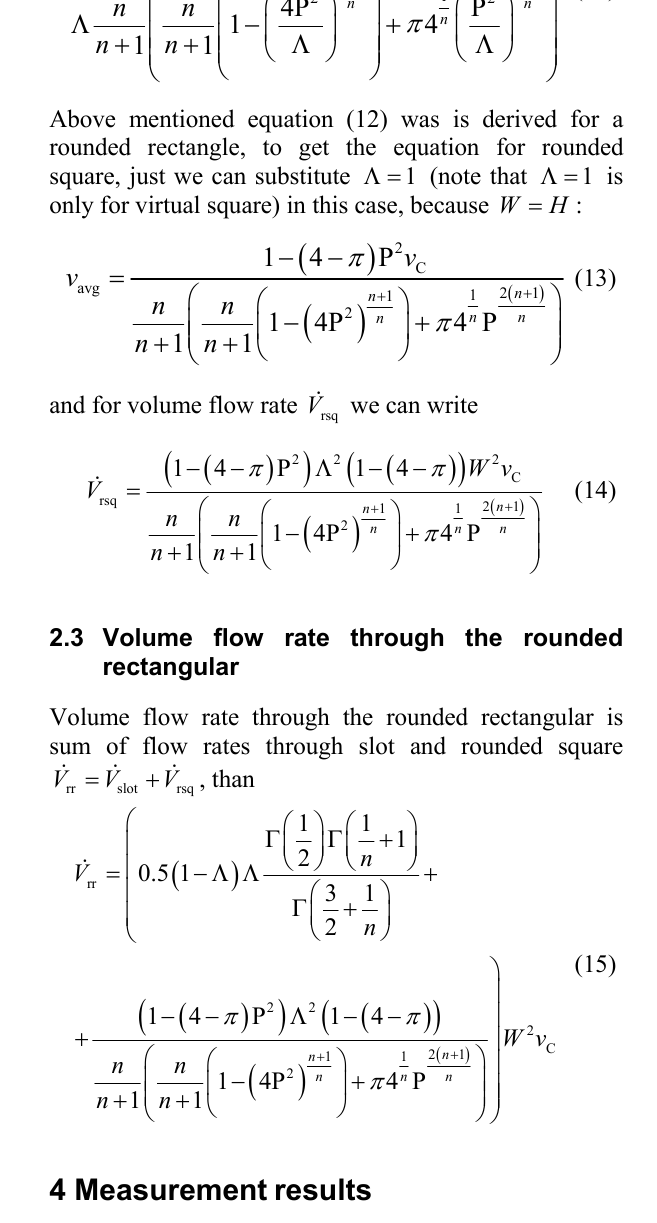
Fig. 5 Idea of virtual rounded square duct Two outer parts of duct cross section together form a square of side H , because of the symmetry and the same velocities on the perpendicular to the axis w dividing lines, passing through points C  and C 